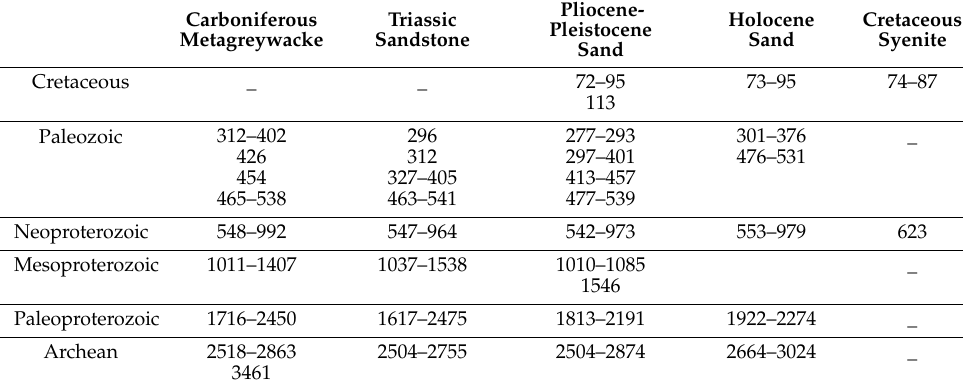
Table 1. Ranges of detrital zircon age groups of the Carboniferous to Pliocene-Pleistocene sili- ciclastic rocks, the Cretaceous plutonic rocks, and the Holocene beach sand (U–Pb data from [16,28,29,34,39,40]). Age intervals are based on laser ablation inductively coupled plasma mass spectrometer (LA-ICP-MS) results with 90–110% concordance. The attribution of U–Pb ages to chronostratigraphic units followed the International Chronostratigraphic Chart v2020/01. Values are expressed in